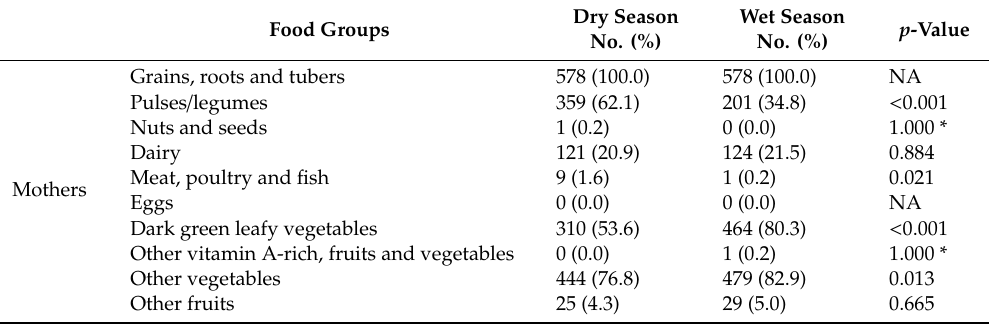
Table 2. Comparison of food group consumption in MCP between postharvest dry and lean